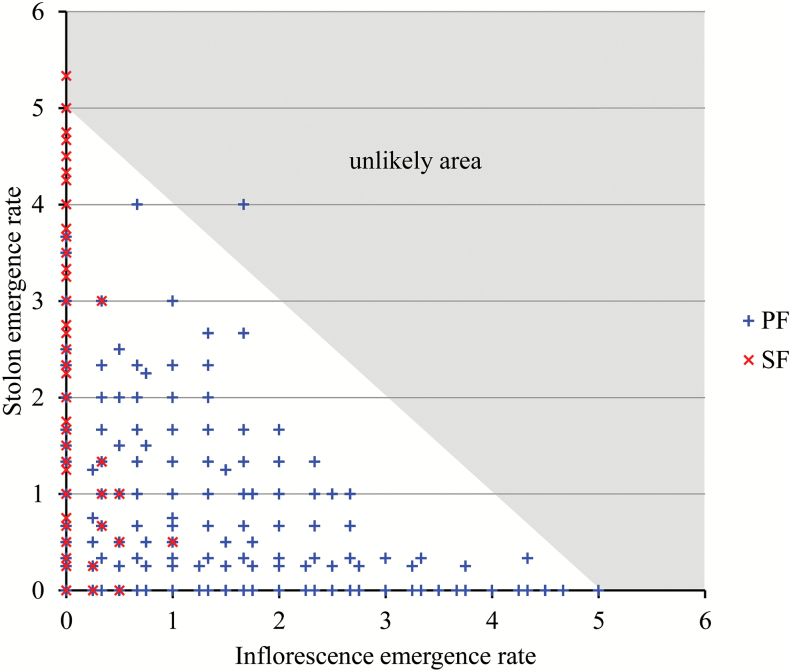
Relation between the inflorescence and the stolon emergence rates distinguishing perpetual flowering (PF) and seasonal flowering (SF) individuals. The area where the combination of inflorescence and stolon emergence rates are very unlikely is indicated.